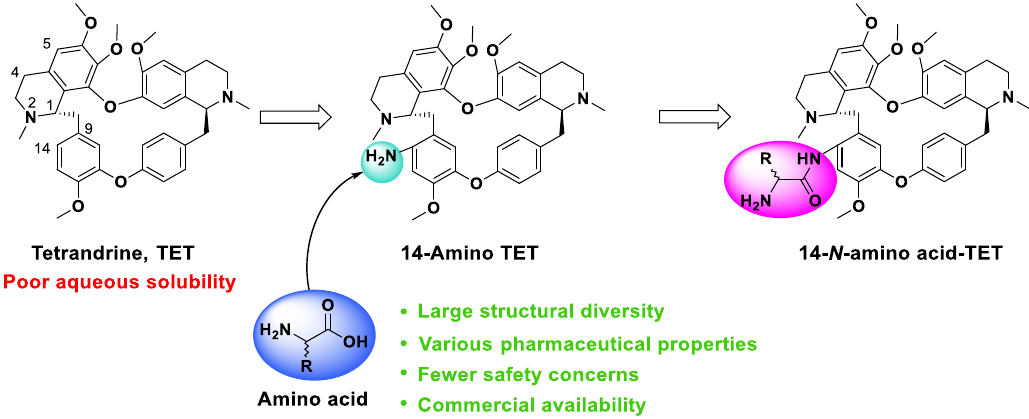
Figure 1. Design strategy of amino acid derivatives of TET.